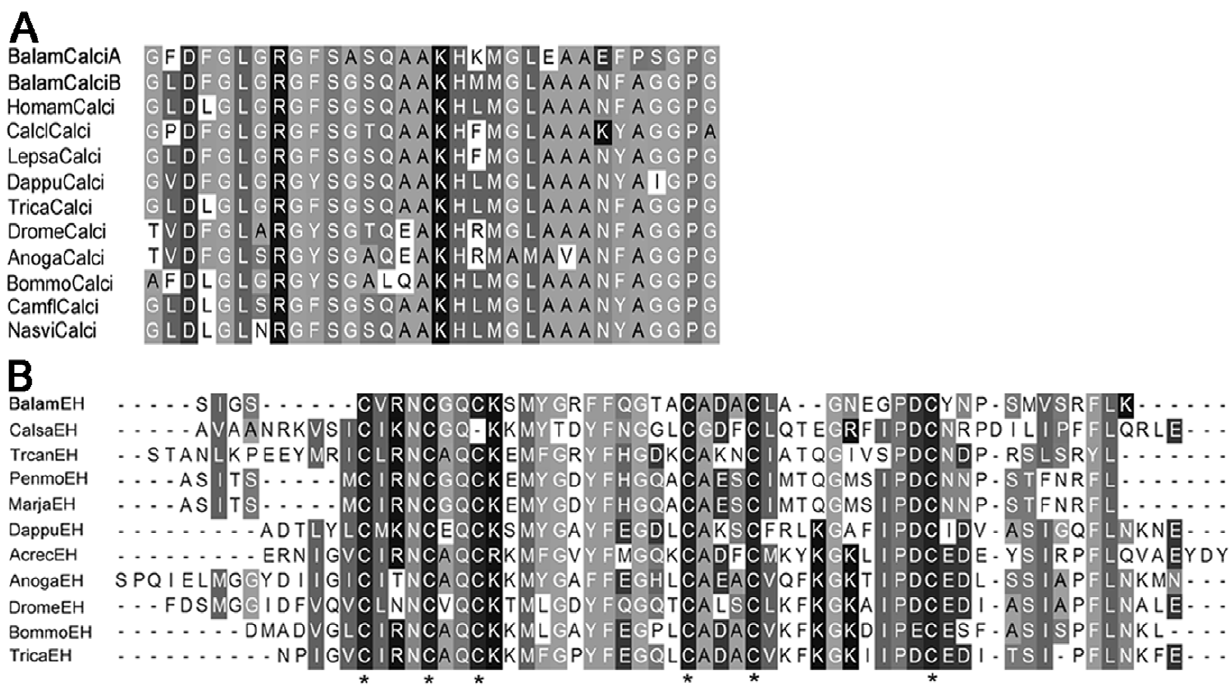
Figure 9. Sequence alignment of calcitonin and eclosion hormone of barnacle. (A) Sequence alignment of barnacle calcitonin isoform A and B. Sequences are from: decapods Homarus americanus ACX46386.1; copepods Caligus clemensi [22], Lepeophtheirus salmonis ADD38663; branchiopod Daphnia pulex EFX90445; insects Tribolium castaneum EEZ99367, Drosophila melanogaster NP_523514, Anopheles gambiae XP_321755, Bombyx mori NP_001124379, Camponotus floridanus EFN61187 and Nasonia vitripennis XP_001599948. (B) Alignment of barnacle eclosion hormone. Sequences are from: decapods Callinectes sapidus CV224237, Penaeus monodon [22], Marsupenaeus japonicus [22]; branchiopods Daphnia pulex [37], Triops cancriformis [22]; insects Acromyrmex echinatior EGI68318, Anopheles gambiae XP_001230805, Drosophila melanogaster NP_524386, Bombyx mori NM_001043842 and Tribolium castaneum XP_969164. Asterisks ‘‘*’’ mark the six conserved Cysteine residues in EH.